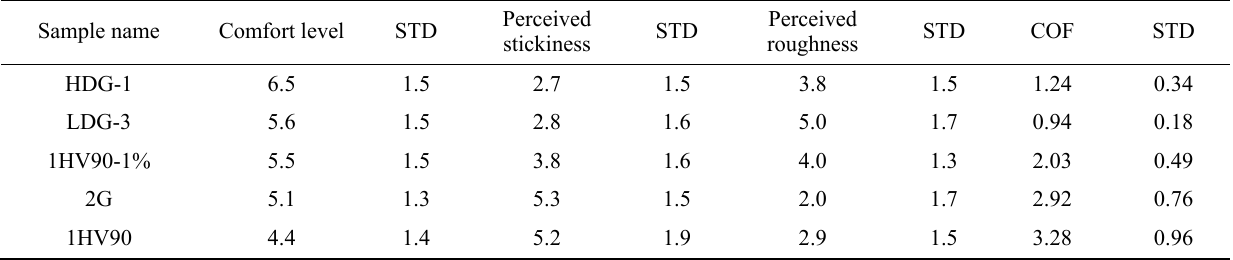
Table 2 The geometric mean of perceived stickiness, perceived roughness, comfort level of sixteen participants from perception experiments; the average values of COF with standard deviations (STD) from friction